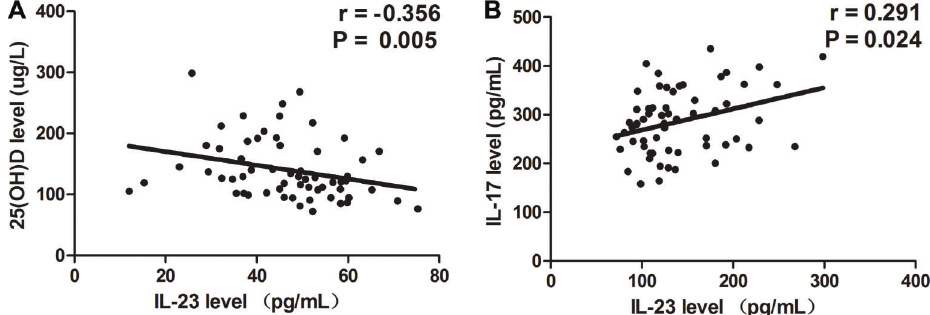
Figure 2. Correlation between 25-hydroxyvitamin D (25(OH) D) and interleukin-23 (IL-23, P=0.005) ( A ), and between interleukin-17 (IL-17) and interleukin-23 (IL-23, P=0.024) ( B